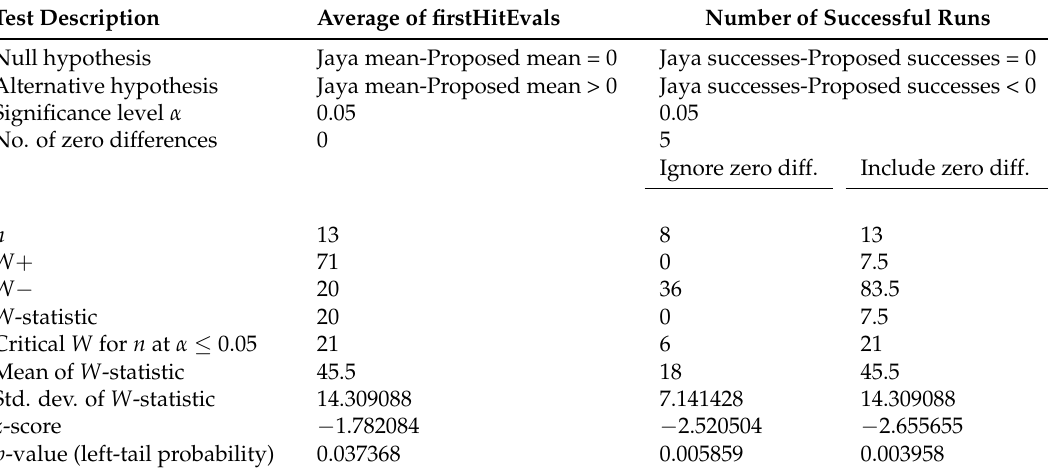
Table 9. Wilcoxon signed rank tests on the data in Table 7 (sample size =